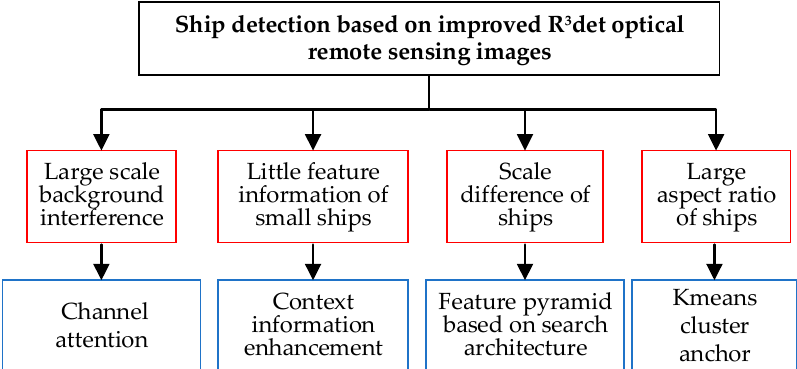
Figure 6. Problems and improved methods of ship detection based on R 3 Det.